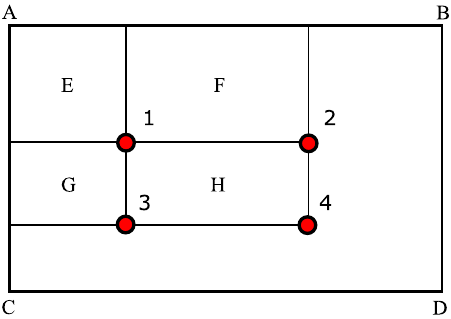
Figure 4. Integral window pixel value computation.